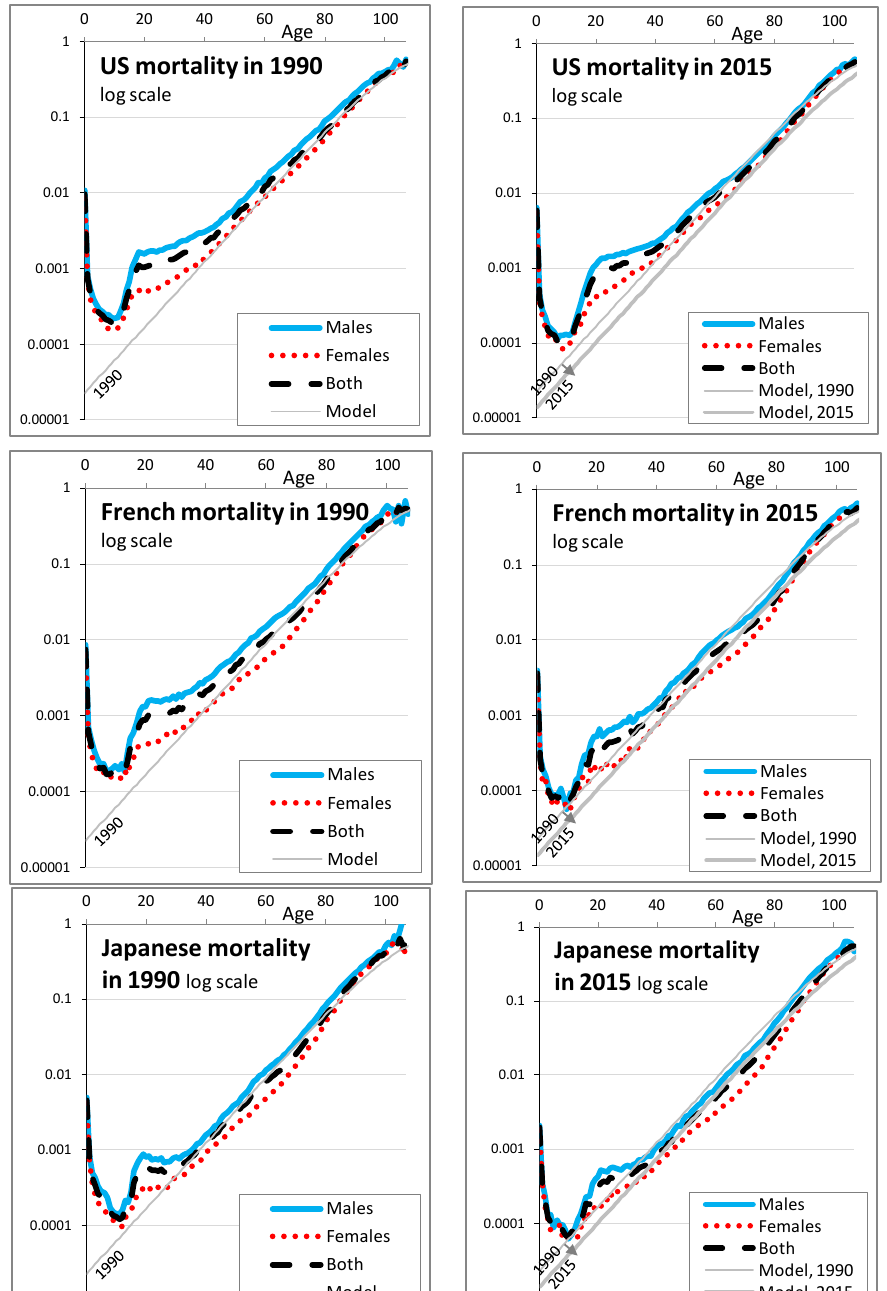
Figure A1. Historical mortality rates, for three countries and as modeled. Annual mortality rates are shown in log scale as function of age, for the USA, France and Japan (graphs from top to bottom), in 1990 and in 2015 (graphs on the left and on the right). Each graph shows the mortality of males in a (blue) continuous line, the mortality of females in (red) dots, the mortality of both in (black) dashes and the mortality of the model used in this article in a gray line that is visually straight up to age 85. For the graphs on the right, the mortality of the model in 1990 is added to help visualize the change of mortality between 1990 and 2015.